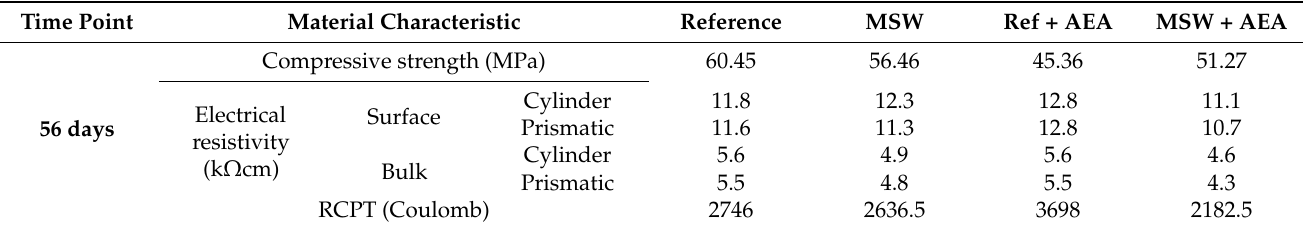
Table 4. Laboratory test results at 56 days.